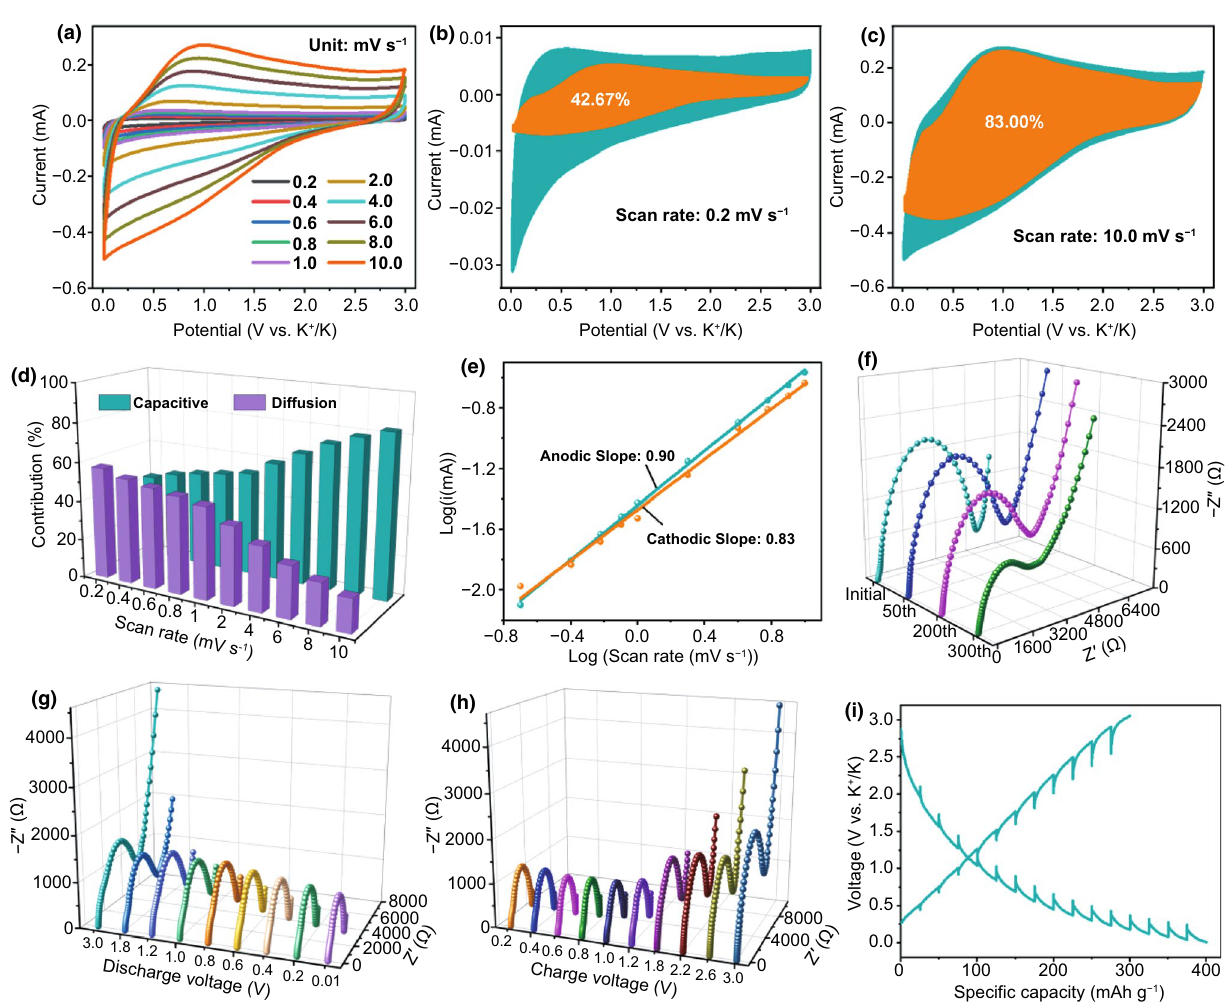
Fig. 4 Properties of the MCS-7-900 electrode. a CV curves corresponding to various scan rates. Capacitive charge-storage contribution at the scan rates of b 0.2 mV s −1 and c 10 mV s −1 . d Contribution ratios of capacitive- and diffusion-controlled effects. e Relationship between log ( i ) versus log ( v ) of the anodic and cathodic peaks. f Nyquist plots after different cycles from initial to 300th cycle at 1000 mA g −1 . Ex-situ EIS plots of g discharge process and h charge process in the sixth cycle at 50 mA g −1 . i GITT potential profiles for the MCS-7-900